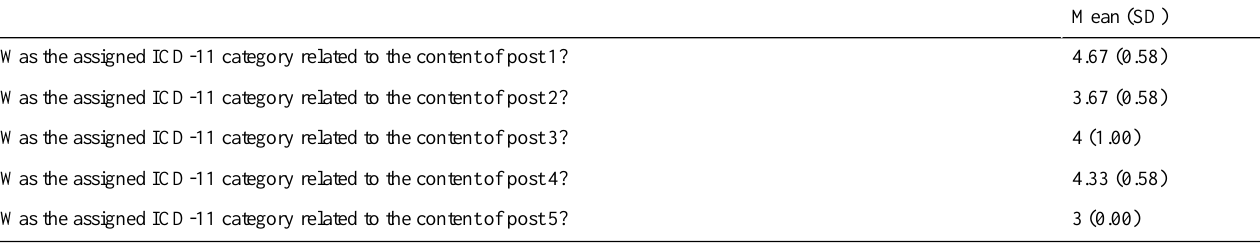
Table 9. Relatedness of the ICD-11 categories to the aggregated cardiology posts.